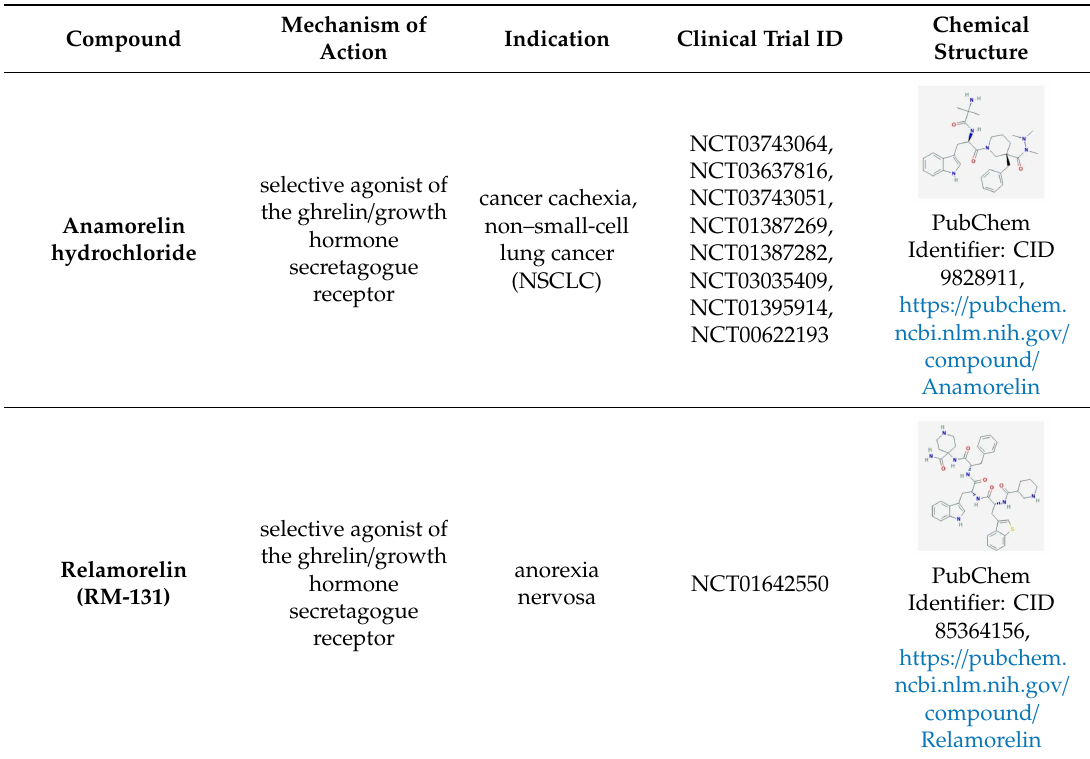
Table 1. Current clinical trials on muscle cachexia